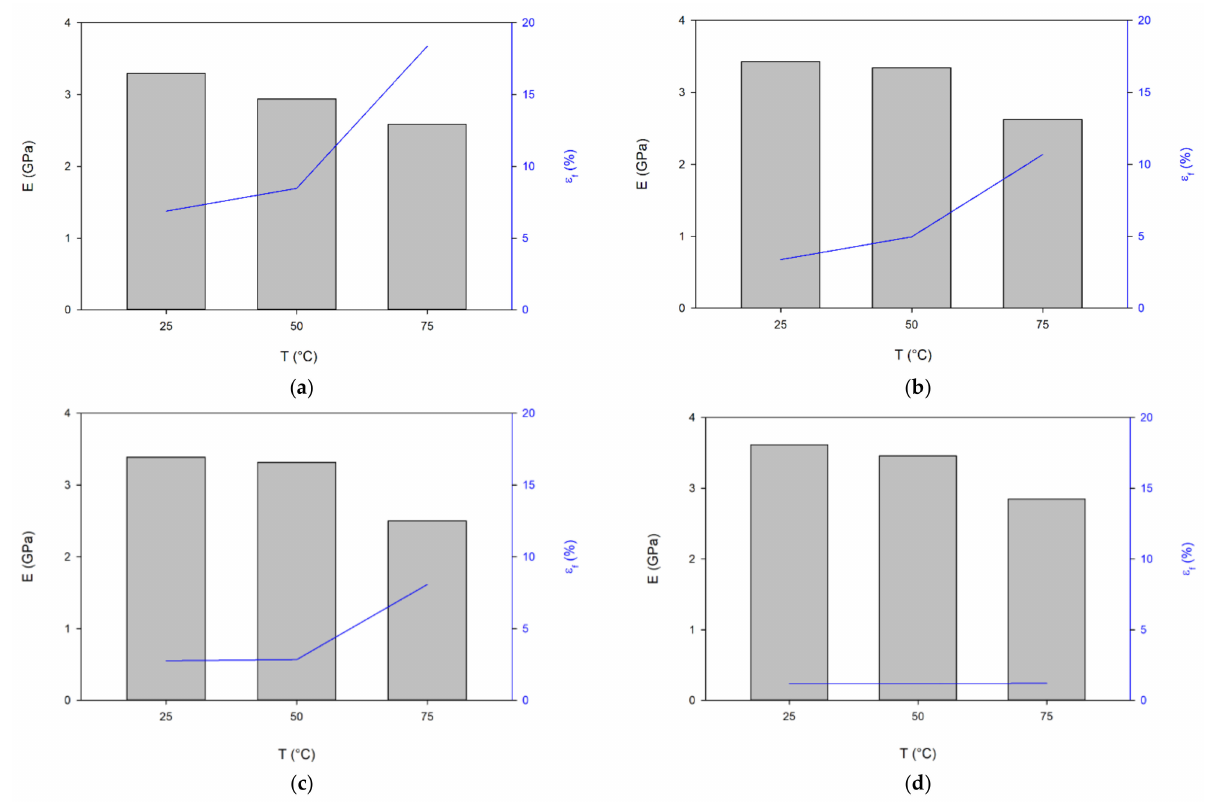
Figure 6. Young modulus (bars) and strain fracture (line) ( a ) as received; ( b ) 21 days aged; ( c ) 35 days aged; ( d ) 56 days